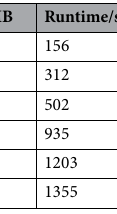
Table 4. The relationship between runtime and data size.